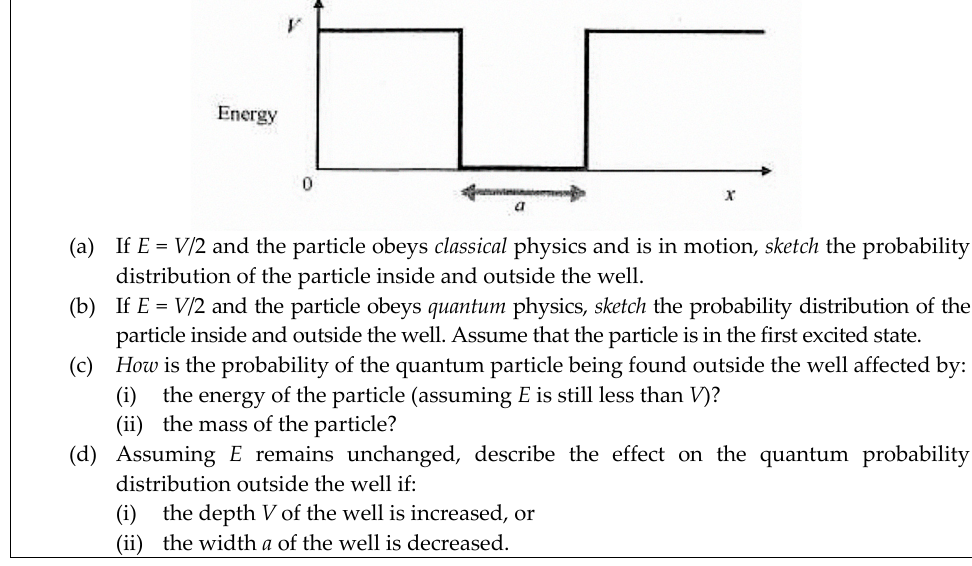
Figure 2. Think-aloud physics Questions 1 and 2 used for examination of transfer processes.